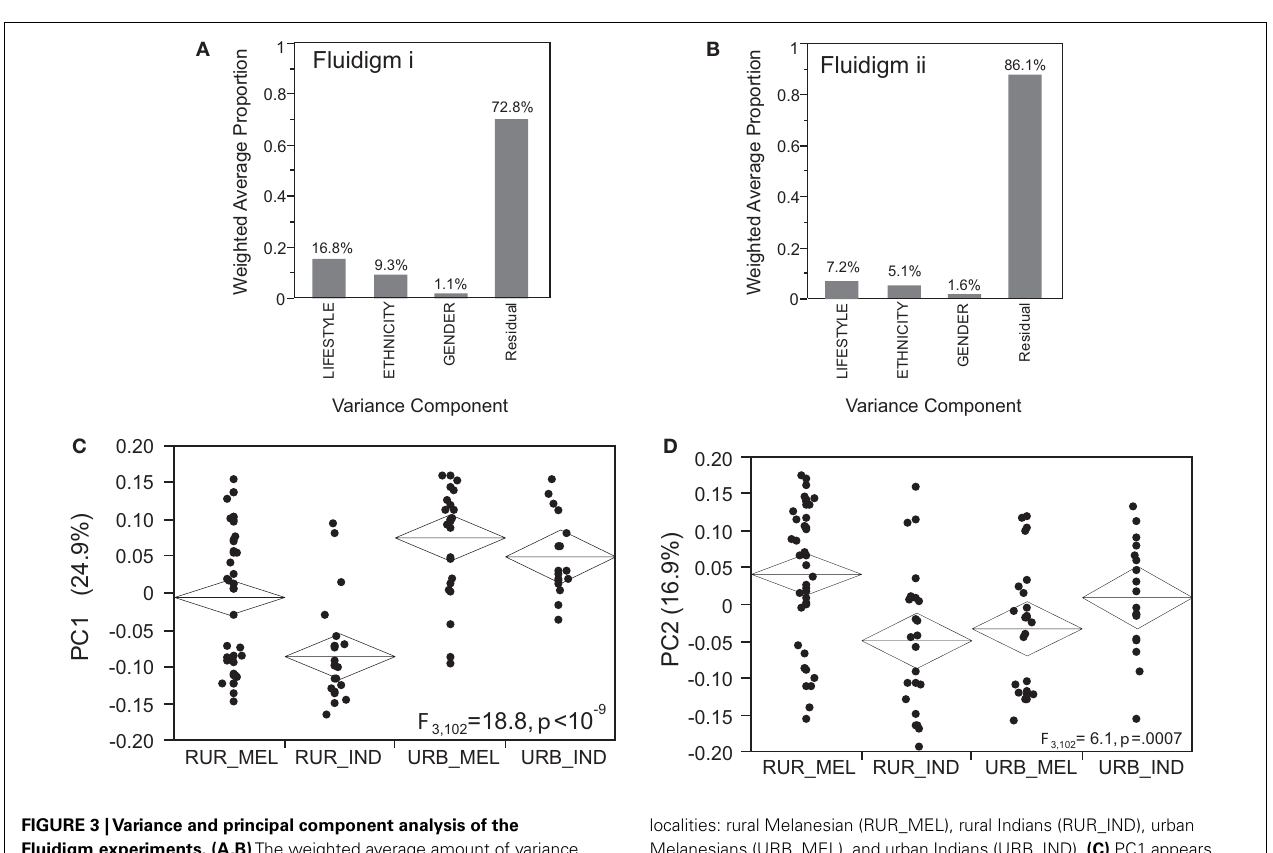
FIGURE 3 |Variance and principal component analysis of the Fluidigm experiments. (A,B) The weighted average amount of variance captured by Lifestyle, Ethnicity, and Gender in each of the two Fluidigm experiments (the Gender effect is not significant by permutation). (C,D) Each plot shows the PC1 (A) or PC2 (B) score for each individual in Fluidigm experiment I, clustered by lifestyle and ethnicity for the four